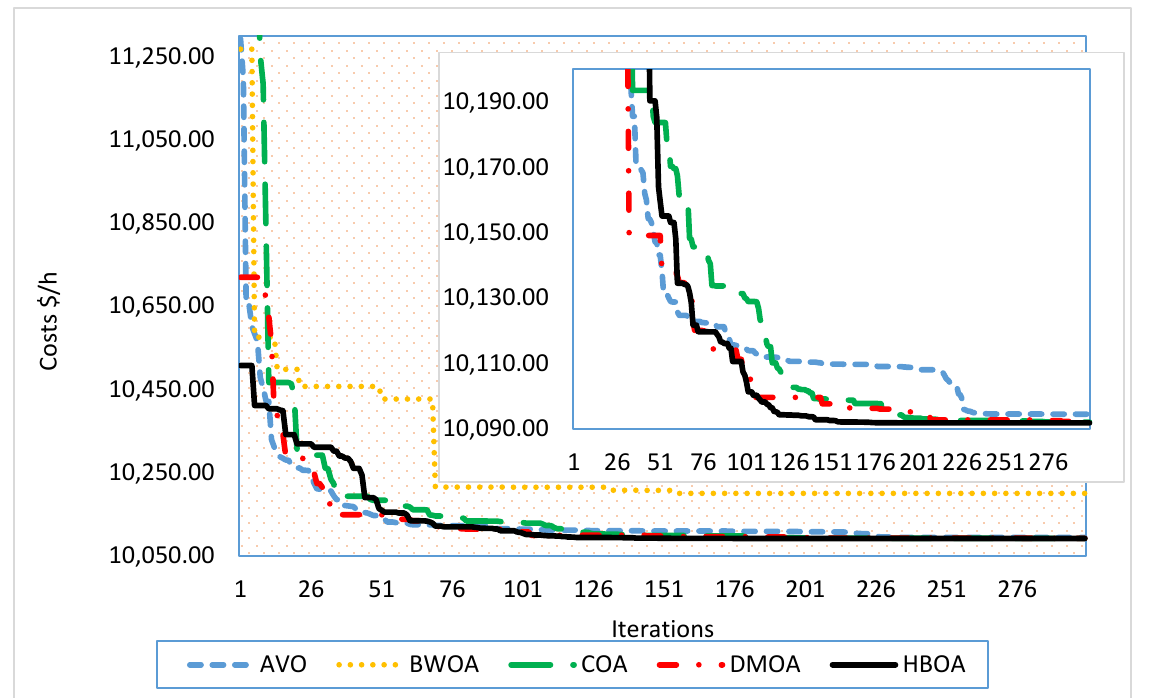
Figure 6. Convergence rates of the proposed HBOA and the AVO, DMOA, COA, and BWOA of Case 2 for the first loading.